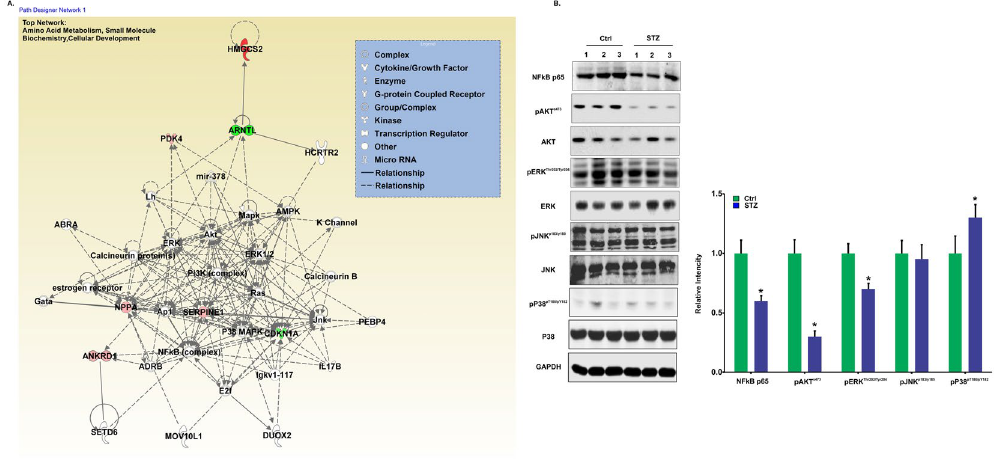
Figure 5. Functional gene networks identified using IPA for STZ-induced T1D with cardiac dysfunction. ( A ) Representative diagram of top network identified named as Amino acid Metabolism, Small Molecule Biochemistry, Cellular Development (IPA score 17). Nodes represent genes, whereas shapes represent a functional class of gene product. Intensity of the node color indicates the degree of overexpression (red) and the degree of down-regulation (green). Genes in uncolored nodes were not identified as differentially expressed and were integrated into computationally generated networks based on information in the IPA database. The network diagram was generated by Ingenuity ® Pathway Analysis software (QIAGEN, Bioinformatics, Redwood City, CA), www.qiagenbioinformatics.com. ( B ) Differential expression profile of MAPKs and NFkB in heart tissue of the control and STZ treated